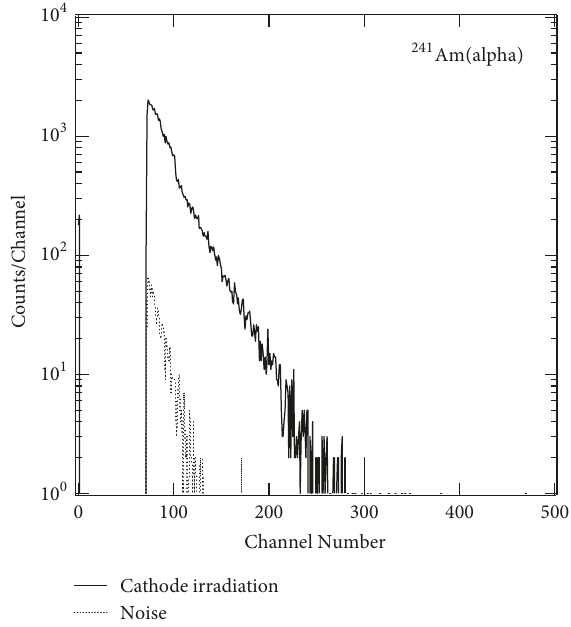
Figure8:Alpha-particleenergyspectrumoftheSbI 3 detectorunder cathode irradiation (electrons mainly transport in the crystal).